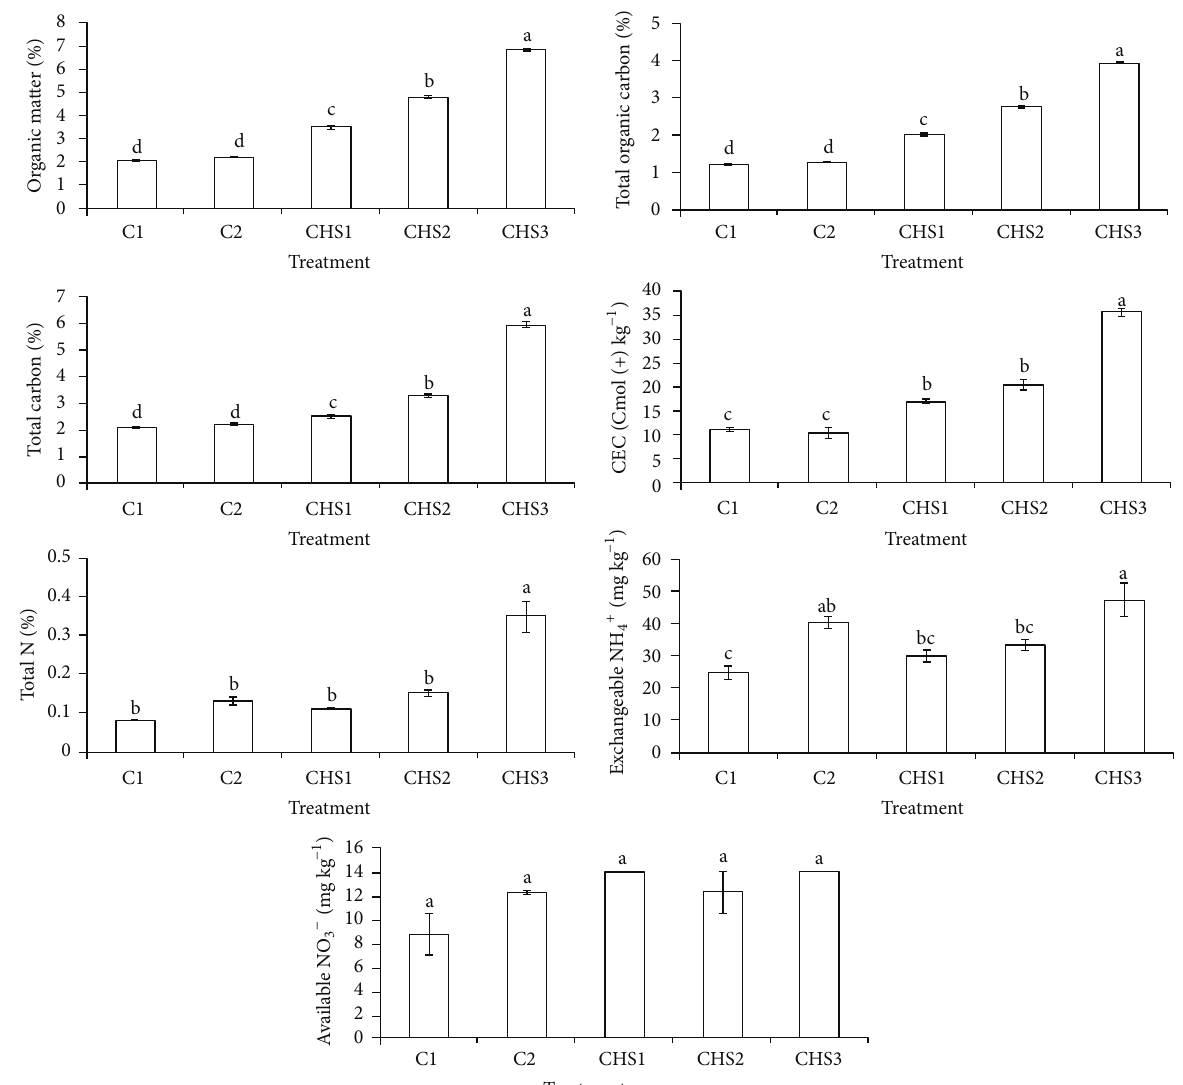
Figure 8: Treatments (C1: soil alone, C2: soil + complete fertilization, CHS1: soil + complete fertilization + 20 g rice straw compost + 2 g sawdust ash, CHS2: soil + complete fertilization + 40g rice straw compost + 4g sawdust ash, and CHS3: soil + complete fertilization + 60 g rice straw compost + 6g sawdust ash) effect on soil total carbon, total organic carbon, organic matter, cation exchange capacity, exchangeable NH 4+ , available NO 3− , and total nitrogen content at 90 days after seeding. Different alphabets indicate significant difference between means using Tukey’s test at 𝑃 ≤ 0.05 . The error bars are the ± standard error of